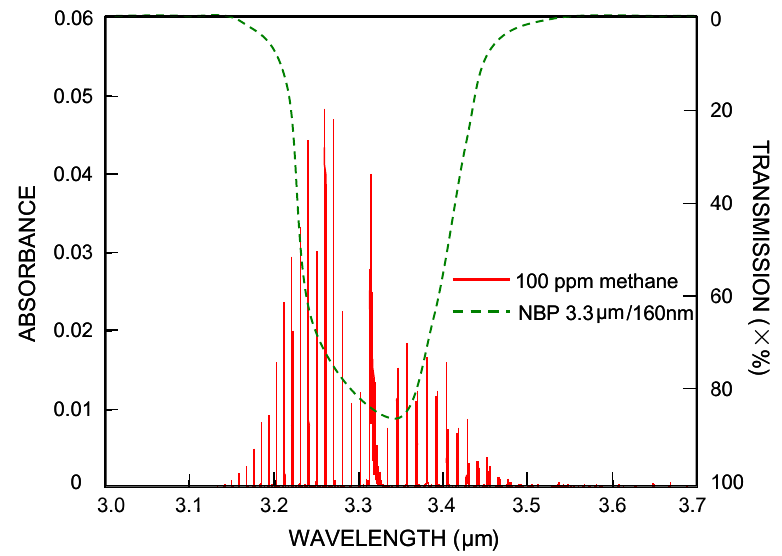
Figure 1. Simulation of methane absorption spectrum near 3.3 µm and transmission spectrum of the bandpass